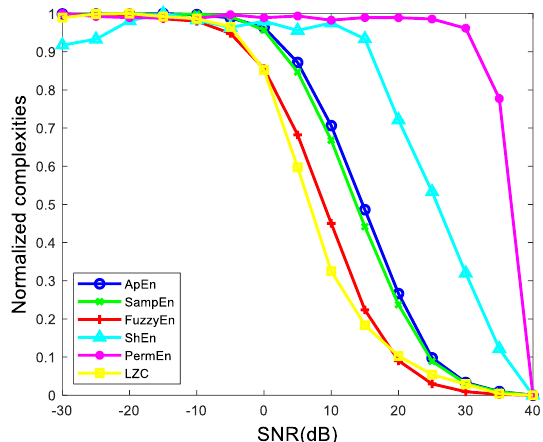
Figure 9. The curve of six complexities versus SNRs.